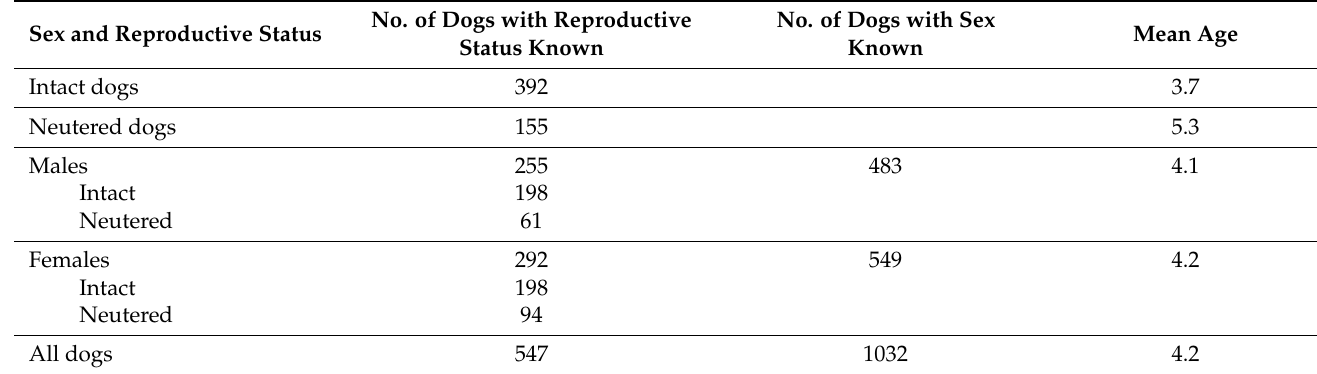
Table 1. Mean ages and number of dogs included in the analysis, divided by sex and reproductive